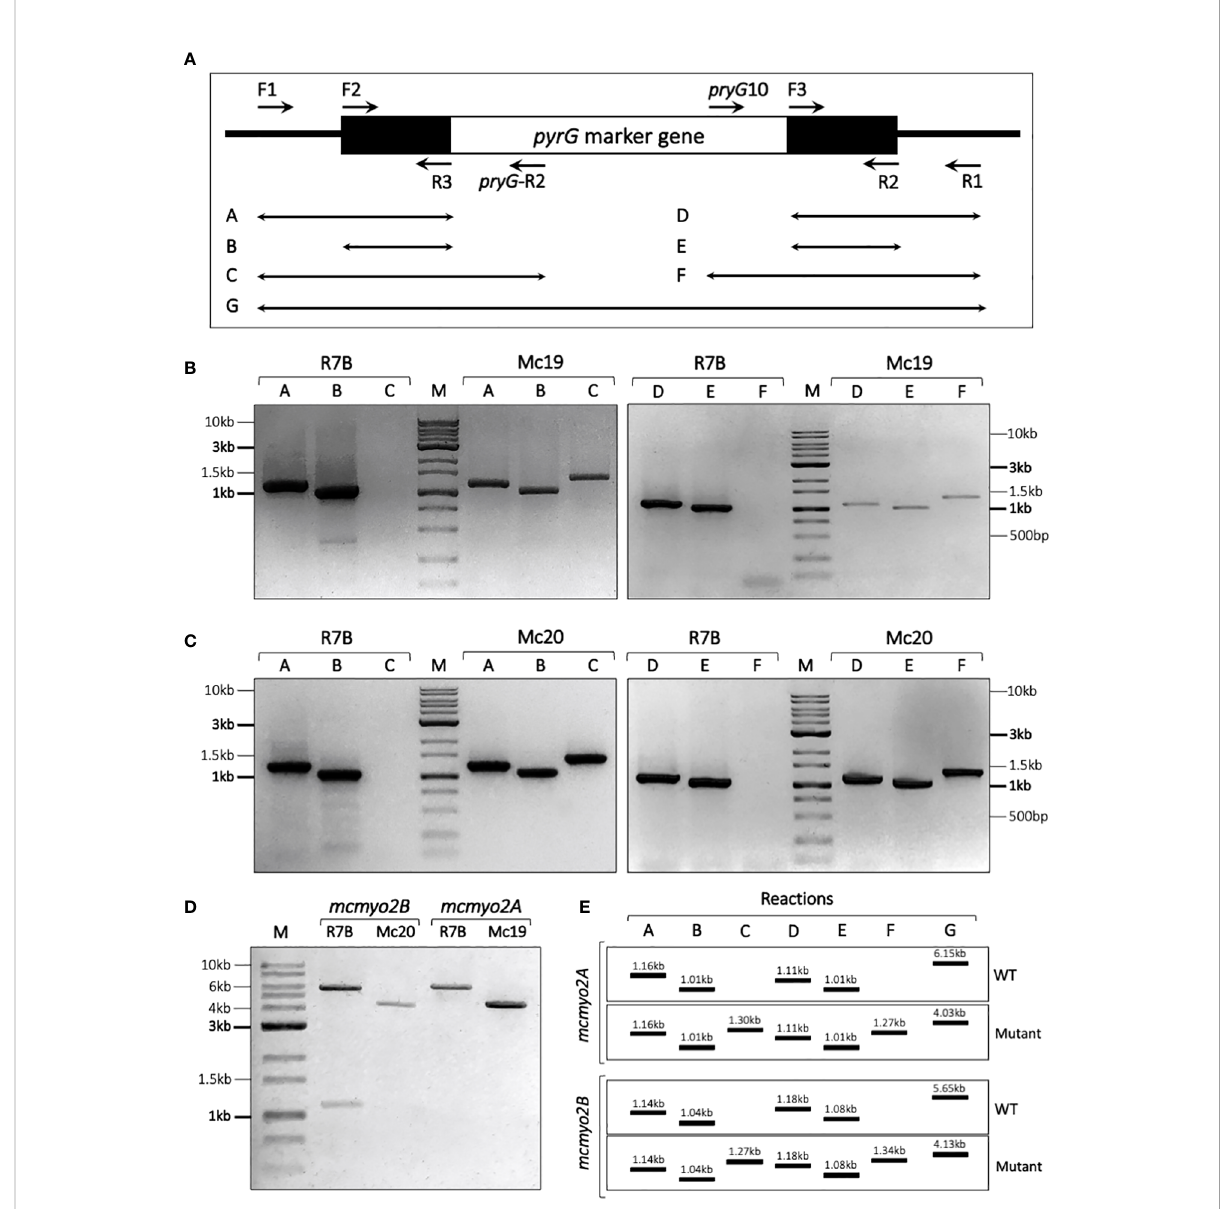
FIGURE 3 Veri fi cation of transformants using PCR-based strategy. (A) Schematic diagram illustrating the location of primers along the disruption cassette in the replacement site and the combination of primers used in each PCR reaction. The black line denotes the replacement site. The black boxes denote the upstream and downstream segments of the target gene, and the white box denotes the marker gene pyrG in the disruption cassette. (E) Expecting results of validating PCR reactions. Validation of transformants corresponding to mcmyo2A ( B ) and mcmyo2B (C) , compared to the control R7B strain (wild-type). (D) Results of PCR (reaction G) to check the genotypes of the